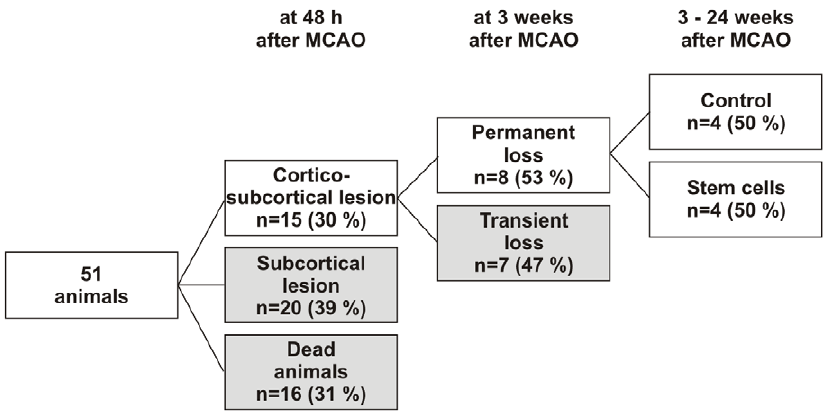
Figure 2. Selection process of the animals for the treatment inclusion. Animals were selected according to the outcome from the MCAO surgery (only subcortical vs. cortico-subcortical lesions) and the fMRI study performed at week 3 (regained vs. non-regained BOLD activation). Finally the remaining animals were randomly asigned to a control and a stem cell-treated group. Gray boxes indicate animals excluded from further procedures at each time point, while white boxes indicate the animals selected for successive stages of the study.